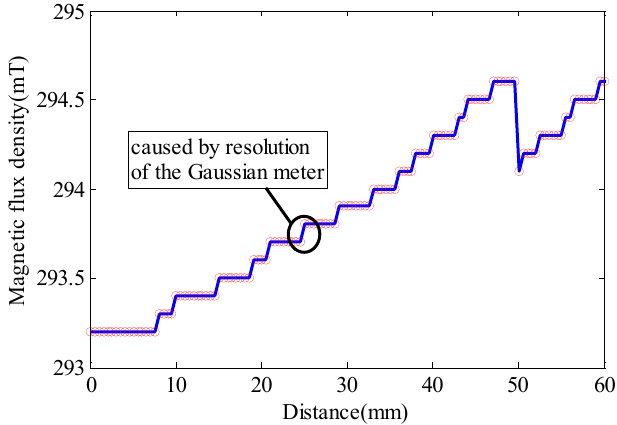
Figure 9. Experimental setup for the magnetic flux density test.